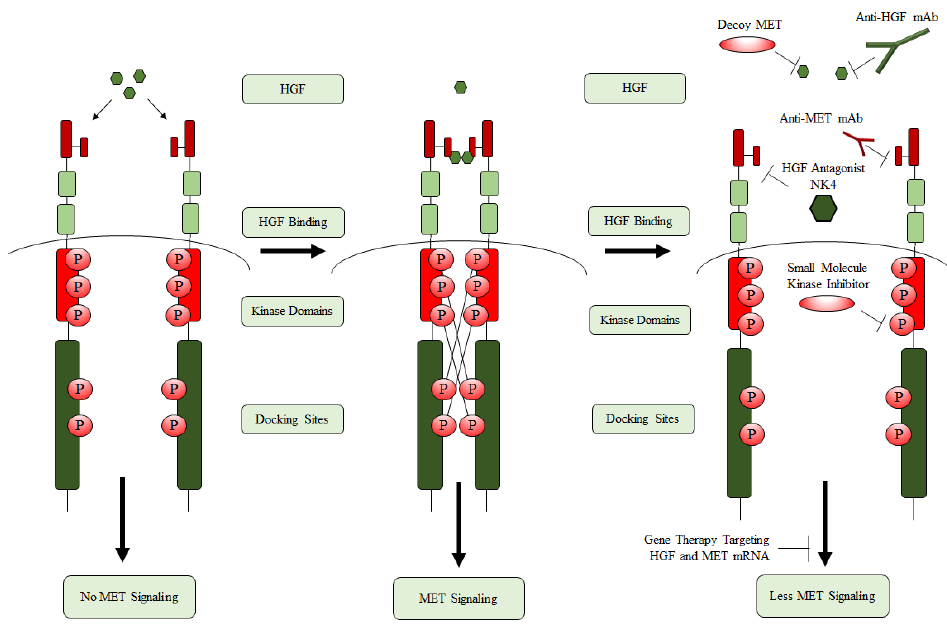
Figure 1. Mechanism of mesenchymal epithelial transition (MET) activation and current therapeutic strategies for hepatocyte growth factor (HGF)/MET inhibition. The MET receptor is activated through ligand (HGF) binding, which induces receptor dimerization and cross phosphorylation. Activation can be inhibited in several ways: (1) Decoy MET protein sequesters HGF from MET, (2) Anti-HGF and MET monoclonal antibodies competitively bind to the ligand and receptor, respectively. (3) HGF antagonists competitively bind to MET. (4) Small molecule kinase inhibitors prevent receptor activation by inhibiting kinase domain activity. (5) Gene therapy modulates HGF and MET mRNA production.